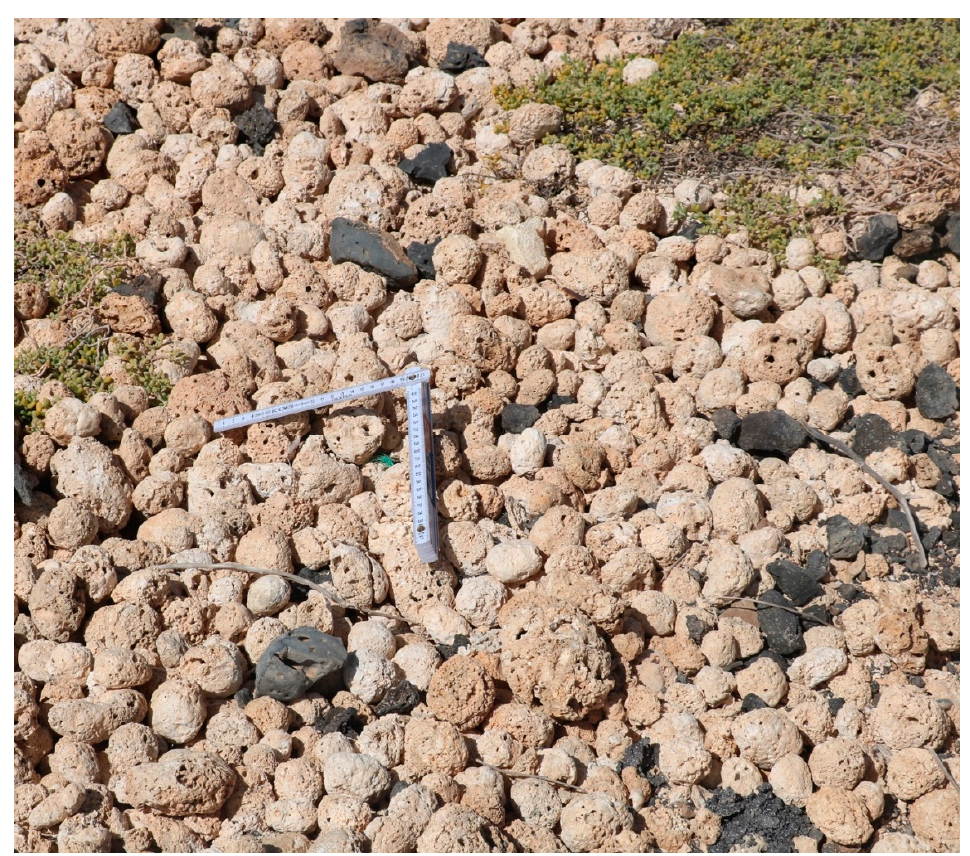
Figure 6. Close-up view of the Holocene supra-tidal deposit at Praía das Gatas (folding meter stick for scale, 20 cm by 20 cm).